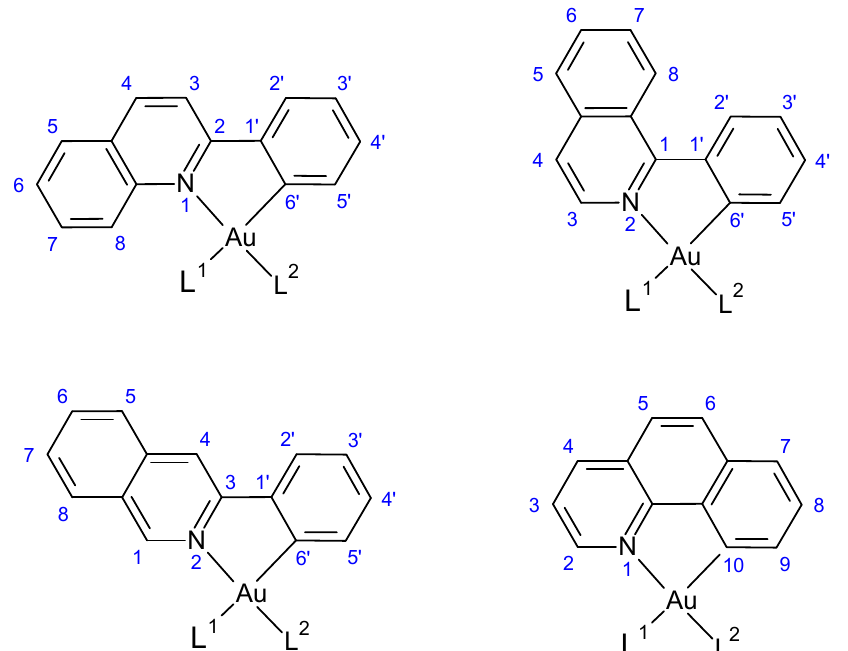
87 Scheme 4. Au(III)-ArPY # * compounds with 2-arylpyridines analogues: 2-phenylquinoline* ( top left ), 1-phenylisoquinoline* ( top right ), 3-phenylisoquinoline* ( bottom left ), 7,8-benzoquinoline* ( bottom right ) with L 1 , L 2 monodentate ligands (in particular—with X halides) or L 1 L 2 bidentate ligand (the latter case is omitted for clarity).